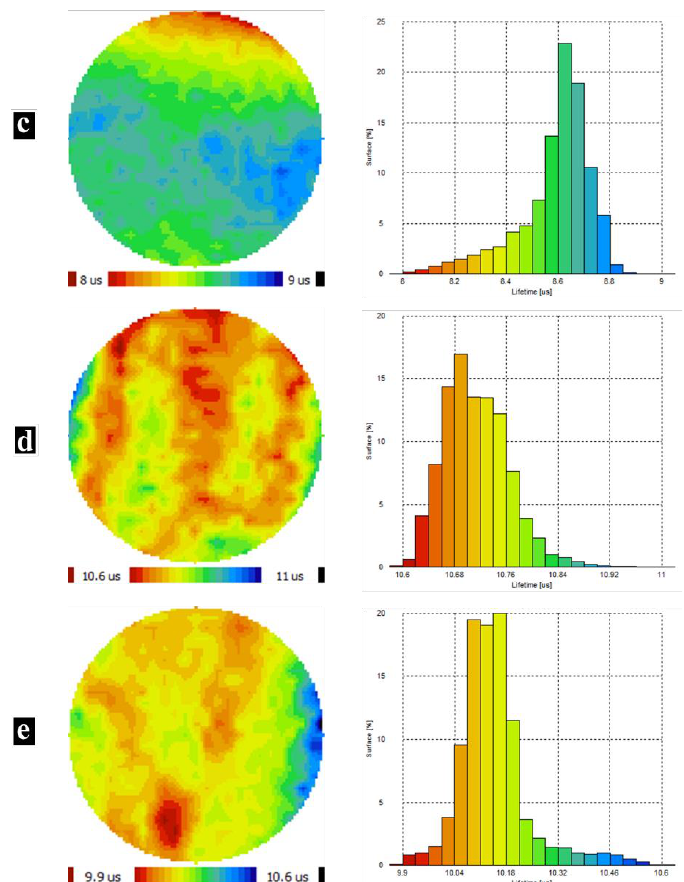
Figure 6. Effective lifetime maps and corresponding histograms of ( a ) bare silicon, ( b ) pure SiNWs, ( c ) Bi-1@SiNWs, ( d ) Bi-2@SiNWs and ( e ) Bi-3@SiNWs.